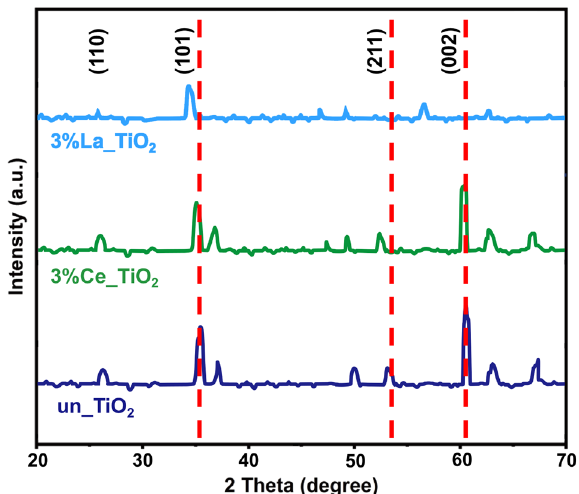
Fig. 1 XRD patterns of un_TiO 2 , 3%Ce_doped TiO 2 , and 3% La_doped TiO 2 polyurea coatings. The diffraction peaks of Ce/La- doped nano-TiO 2 at 2 θ has shifted towards lower angles compared to the nano-TiO 2 (1 0 1) at 2 θ = 36.28°, which was due to the larger radius of Ce/La-dopants (Ce 3 + = 1.02 Å and La 3 + = 0.96 Å) than that of Ti (0.60